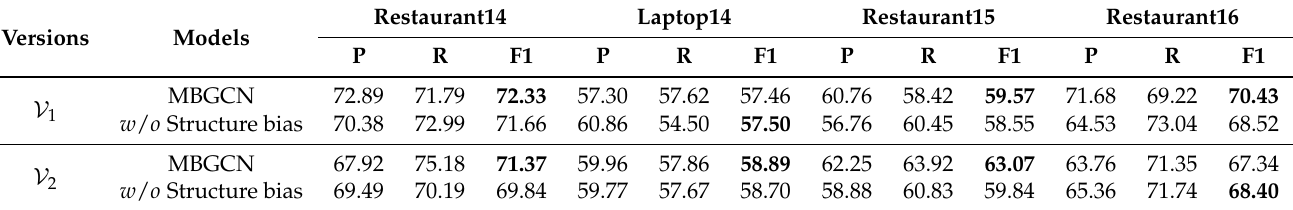
Table 5. The contribution of adapter to MBGCN for ASTE task on V 1 and V 2 . Restaurant14 Laptop14